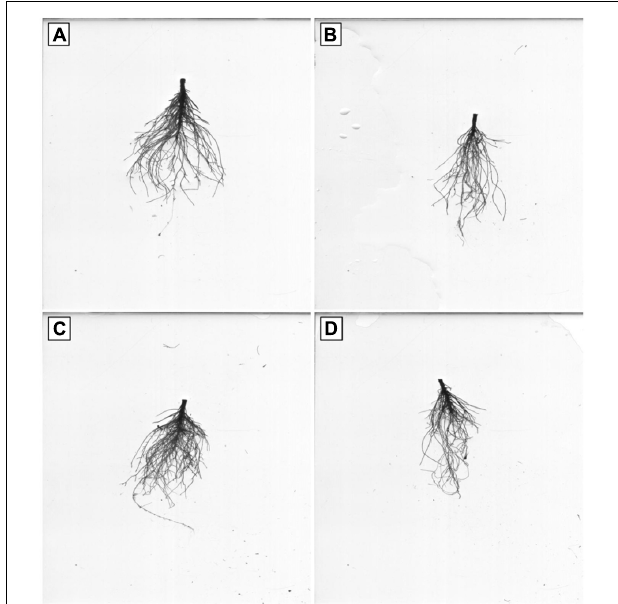
FIGURE 6 | Effects of Pb and GSH on growth and length of primary and secondary roots. Scanned roots represent control (A) , cotton roots treated with 500 µ M Pb (B) , cotton roots treated with 50 µ M GSH (C) and root of plant treated with combined application of 500 µ M Pb and 50 µ M GSH (D)